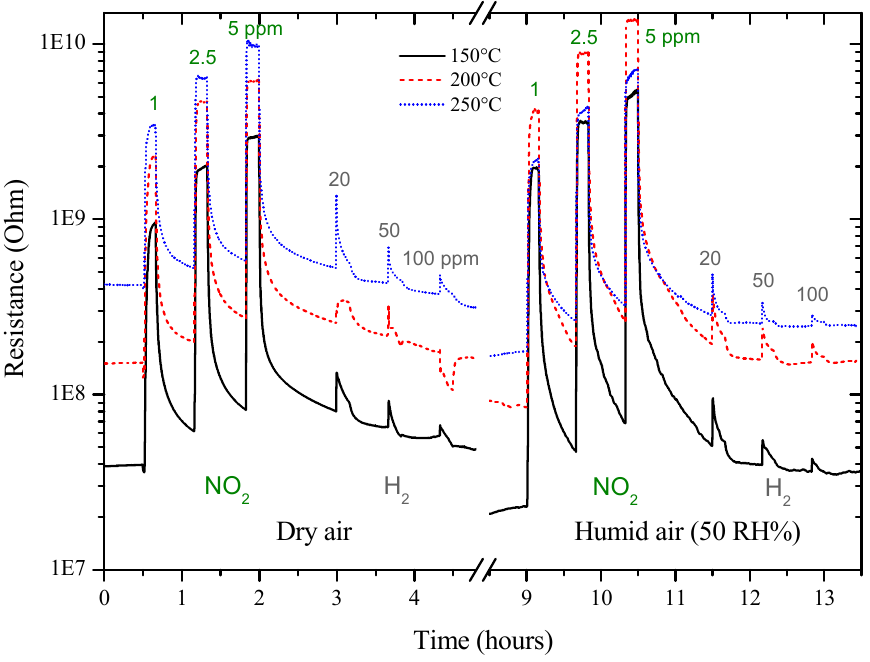
Figure 10. Resistance of sol-gel GC sensor at 150, 200 and 250 °C under NO 2 and H 2 .